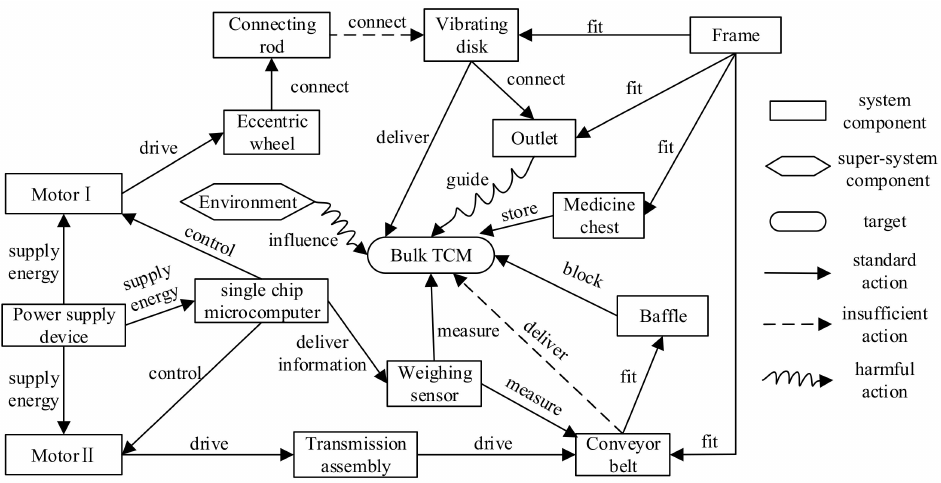
Figure 14. Function model of the bulk TCM